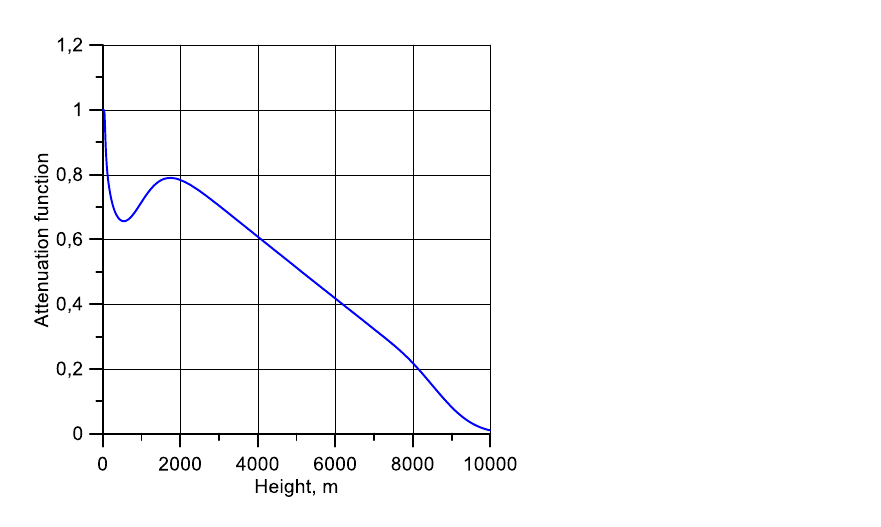
15 of 24 Figure 9. Magnetic field of subsequent return strokes at different distances as predicted by the MTLD model that incorporates current dispersion. ( a ) 50 m, ( b ) 1 km, ( c ) 2 km, ( d ) 5 km, ( e ) 10 km and ( f ) 100 km. The return stroke speed is assumed to be constant and equal to 1.5 × 10 8 m/s. At the beginning of this section, we mentioned that a radiation field exhibiting a sub- sidiary peak is not compatible with a pure MTL-type model. Let us now expand on this statement. First, observe that in calculating the radiation field shown by curve 1 in Figure 7, we used the current attenuation function shown in Figure 4b while incorporating current dispersion into the model. Let us now use this radiation field to extract the apparent at- tenuation function using Equation (12) but without taking into account the presence of dispersion. The resulting attenuation function is shown in Figure 10. Observe that this attenuation function contains a subsidiary peak. According to this attenuation function, there will be a gradual enhancement of the return stroke current at higher levels along the return stroke channel. However, since the return stroke current is transporting positive charge upwards, such a current enhancement can only be possible if the corona sheath supplies a positive charge to the core of the return stroke. This in turn requires the depo- sition of negative charge along the channel where the current enhancement is taking place. We believe that this scenario is physically unreasonable. The second point is that had we used the current attenuation curve shown in Figure 10 in an MTL-type model without dispersion, the resulting electromagnetic fields at different distances would not have dis- played the characteristic features pertinent to the measured fields. For these reasons, we conclude that for uniform or monotonically decreasing return stroke speeds, subsequent